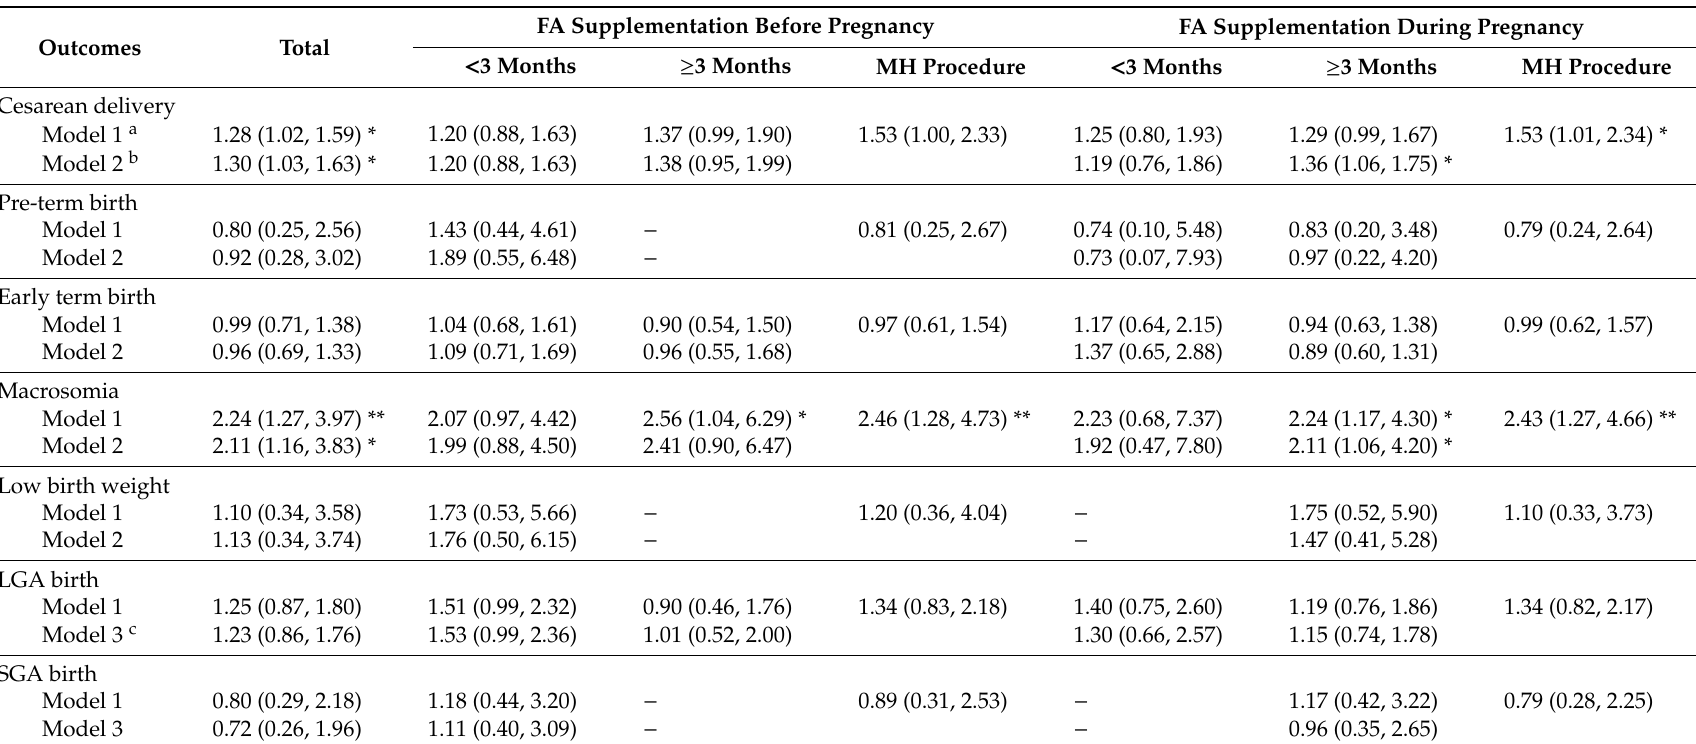
Table 5. Associations between GDM and adverse birth outcomes stratified by duration of FA supplementation.